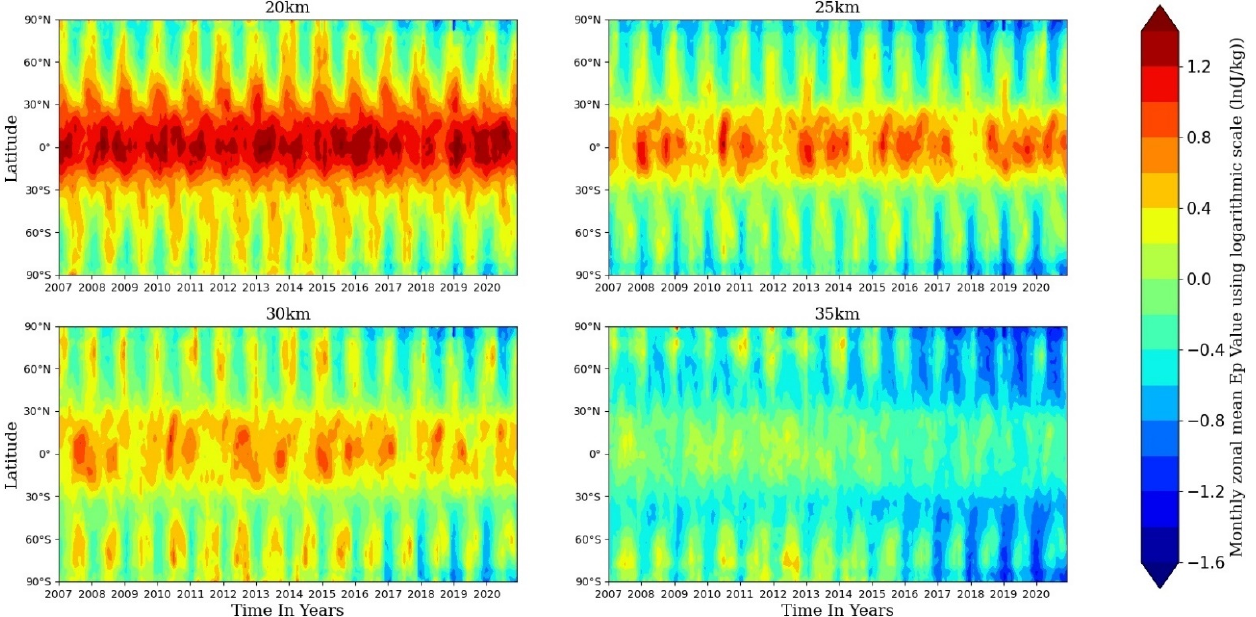
Figure 5. Time–latitude distributions of the GW Ep values at the four height levels: 20 km, 25 km, 30 km, and 35 km. The unit of the color bar is monthly and zonal-mean GW Ep using logarithmic scale (ln(J/kg)).